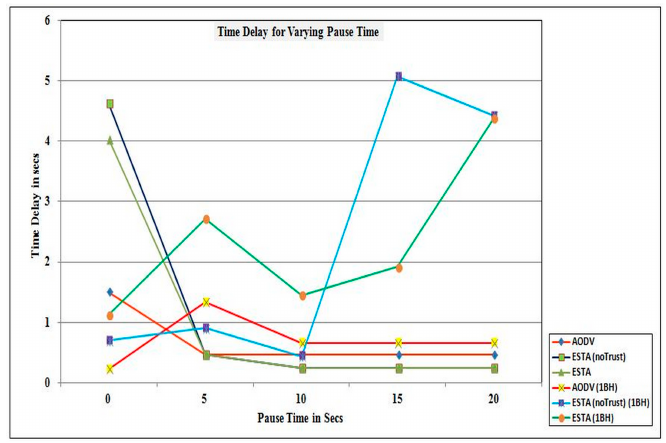
Figure 8. Time delay for varying pause time.